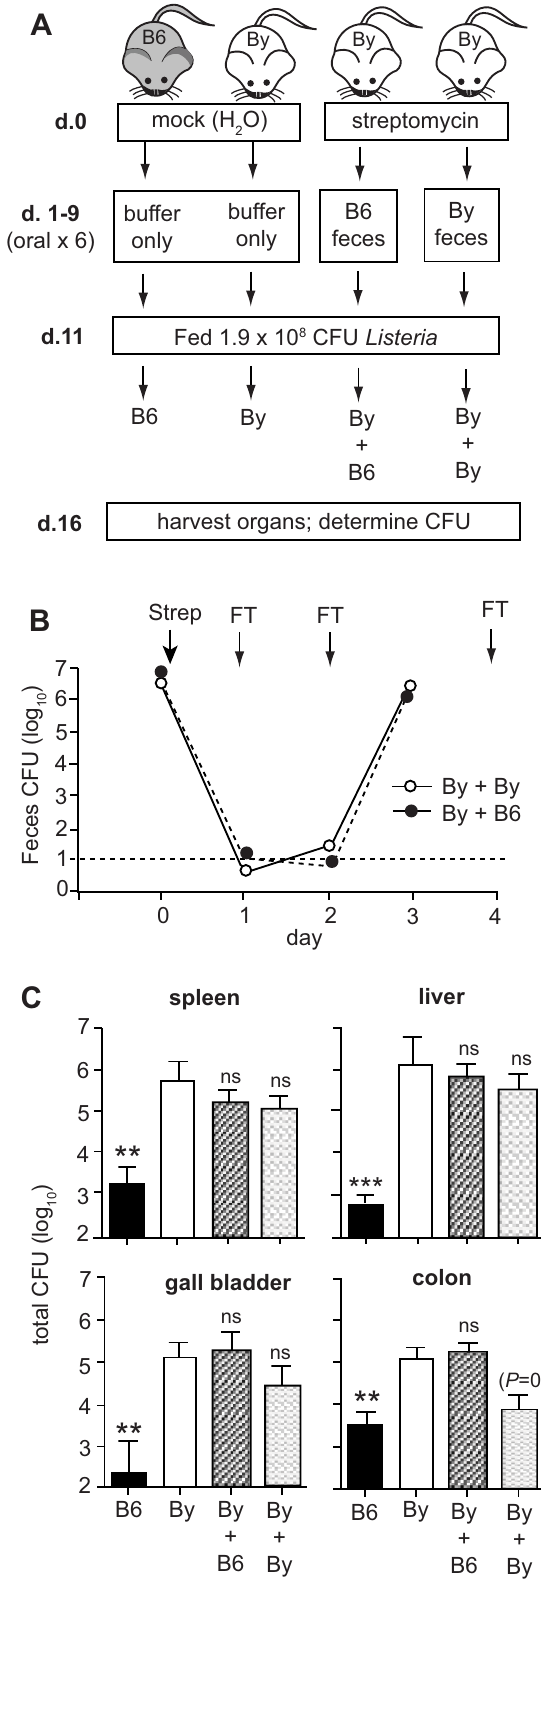
Figure 1. Transplantation of fecal matter from C57BL/6 (B6) mice to BALB/c/By (By) mice does not confer resistance to L. monocytogenes . ( A ) The experimental design for four groups of mice is shown. Mock-treated mice received oral treatments with buffer alone and maintained their original microbiota. Streptomycin- treated mice received a total of 6 fecal transfers over a 9 day period. On day 10, food was restricted and all mice were placed on raised wire flooring for the duration of the experiment. ( B ) The efficiency of streptomycin pre-treatment was evaluated by monitoring the amount of aerobic CFU shed in the feces. Arrows indicate days of either antibiotic treatment (Strep) or fecal transplants (FT). Mean values ± SEM for groups of 8 mice are shown. ( C ) Mean values ± SEM (n=8) for total L. monocytogenes CFU in spleen, liver, or gall bladder and cell-associated CFU in the colon were determined 5 days post infection. Asterisks indicate mean values significantly different from the mock-treated By group as determined by unpaired t-test. Pooled data from two separate experiments comprising 4 mice per group is